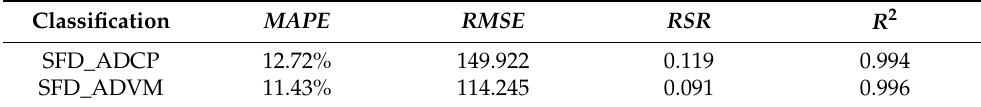
Figure 5. Rating curve considering the backwater effect based on ADVM data. Table 2. Error in the equations for each data